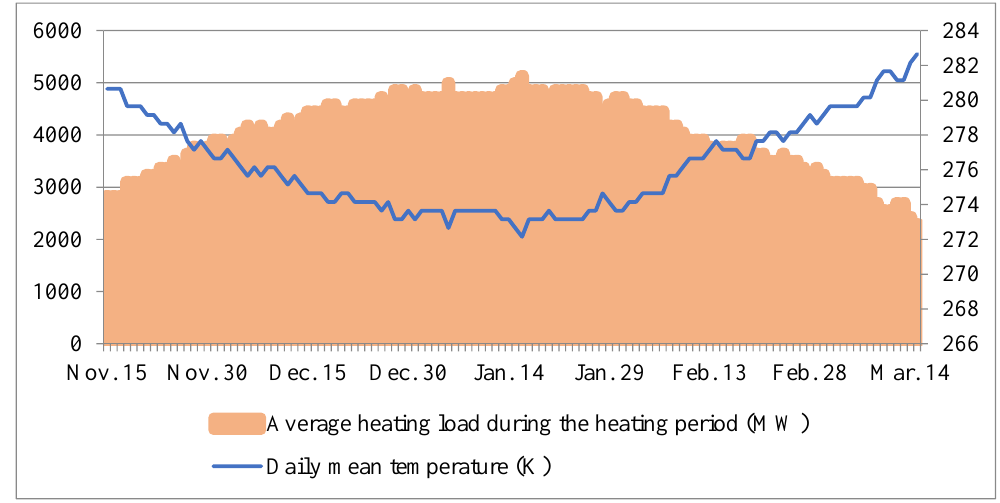
Figure 3. Daily mean temperatures and average heating loads during the heating period in Xi’an.